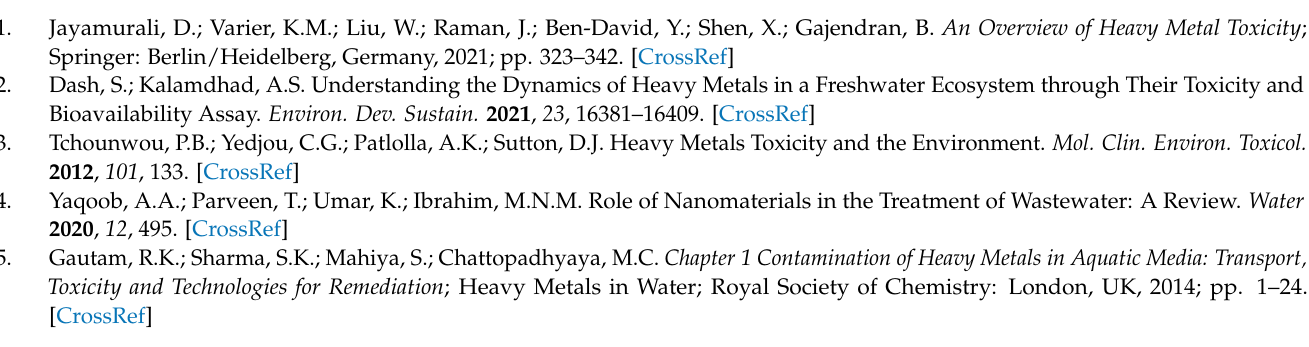
Table S1: Kinetic parameters of Pb(II), Cd(II), Zn(II), Cu(II), and Ni(II) sorption kinetics on the fabricated resins, as determined by fitting with the selected models; Table S2: Isotherm parameters of different models for sorption of Pb(II), Cd(II), Zn(II), Cu(II), and Ni(II) sorption kinetics on the fabricated resins, as determined by fitting with the selected